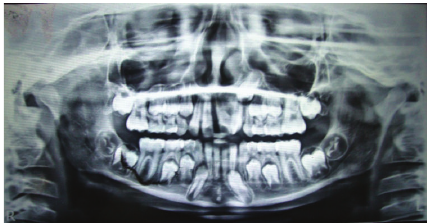
Figure 2: Pretreatment panoramic radiograph showing incomplete fusion of 21 and 22 at crown